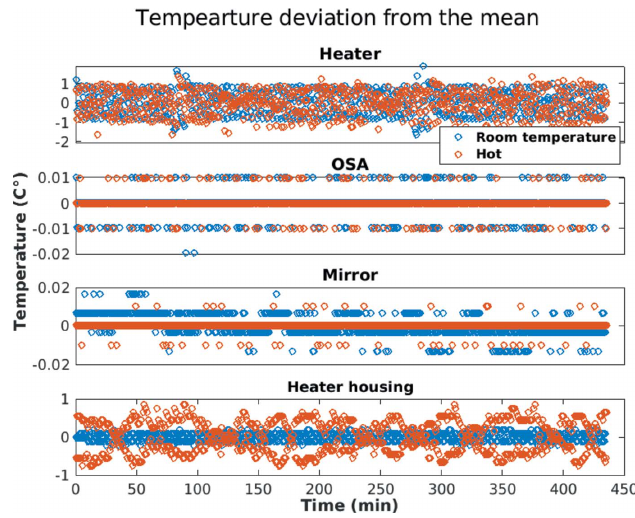
Figure 8 Temperature variations of setup components during tomographic acquisition. The set temperature for the room temperature measurement was 50 (cid:2) C and 600 (cid:2) C for the hot measurement. The mean temperature of the OSA mounting plate was 25.5 (cid:2) C, and the mirror 24.2 (cid:2) C in both cases, while the mean temperature of the heater housing increased from 21 (cid:2) C to 25 (cid:2) C in the hot